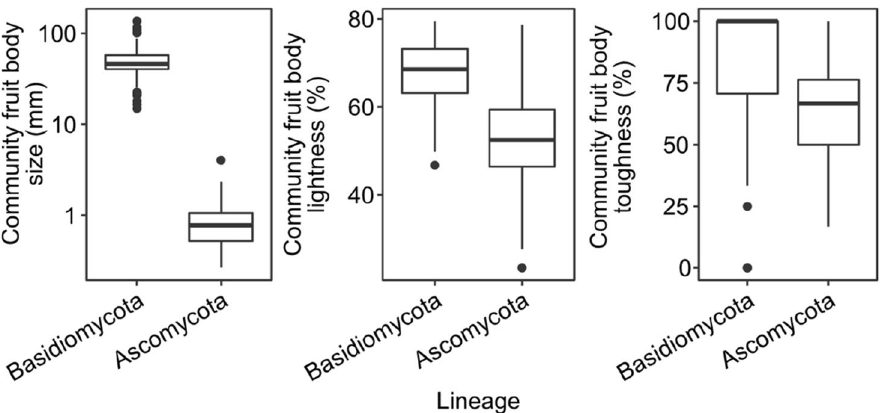
Figure 2. Differences in community fruit body traits between lineages. Note that fruit body size is log 10 - transformed. We used linear mixed-effects models with a nested random effect on block and plot to test for significance. Statistics values are given in the text. R programming environment version 4.1.2 40 and R add-on package ggplot2 41